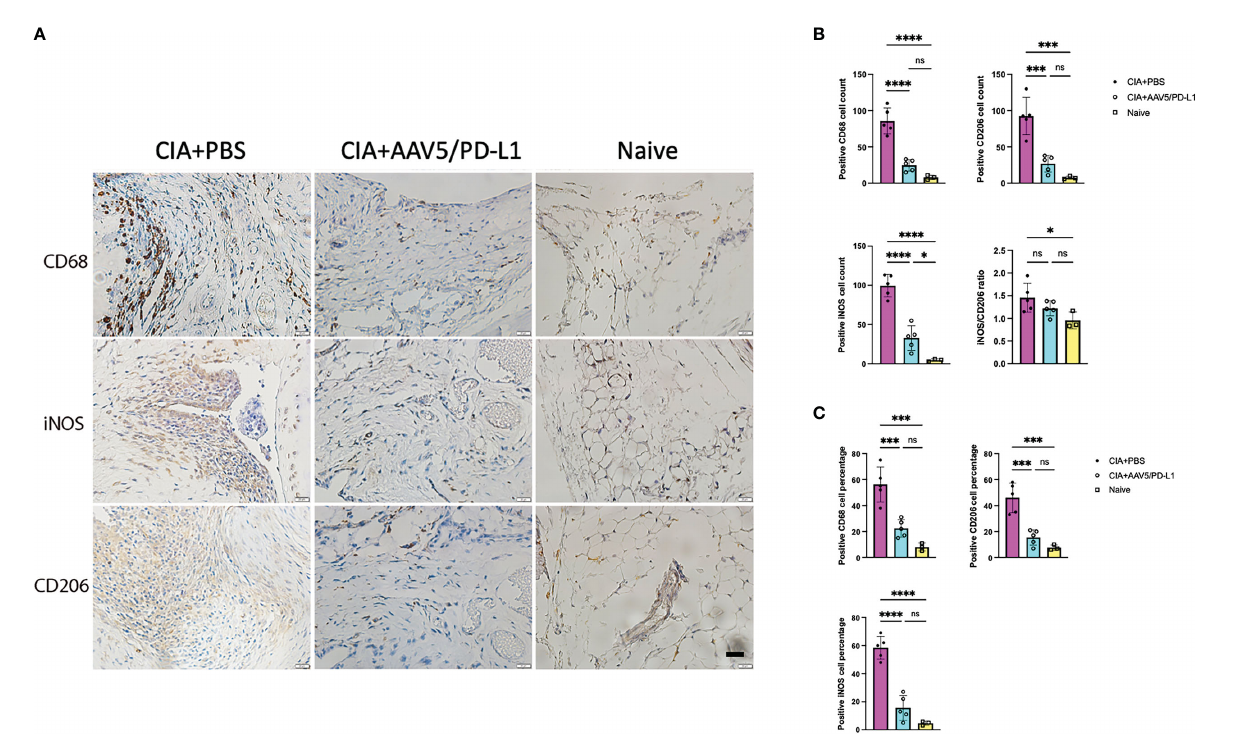
FIGURE 5 Decreased in fi ltration of macrophages in the synovium with PD-L1 prophylactic treatment. (A) , Immunohistochemistry staining for macrophage cells. Representative images of in situ immunohistochemical visualization of macrophages stained with antibodies against CD68, iNOS, CD206 (bar=20 m m) are shown in CIA mouse knees. (B, C) , Total number (B) and cell percentage (C) for CD68, iNOS and CD206. The macrophages were counted from 10 fi elds of view and averaged in each joint for fi ve knee joints. Each dot represents one mouse joint. Mean values are shown with standard derivation (n=5: PBS and AAV5/PD-L1; n=3: naïve). Data was analyzed using one-way ANOVA followed by Bonferroni multiple comparison test for group comparisons. *, p < 0.05, ***, p < 0.005, ****, p < 0.001. ns, not signi fi cant (p ≥